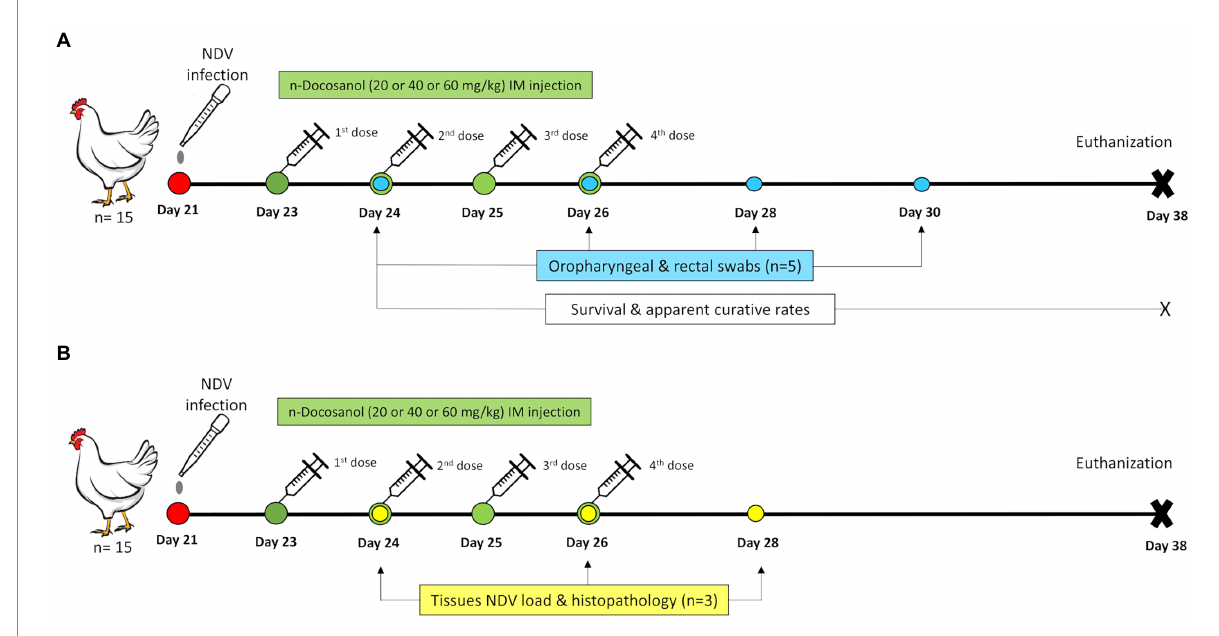
FIGURE 1 Schematic illustration of the experimental timeline for the chickens treated with n -docosanol. (A) The timeline of chicken groups used for the assessment of survival and curative rates and NDV shedding post treatment. (B) The timeline of chicken groups used for the assessment of tissues’NDV load and histopthology post